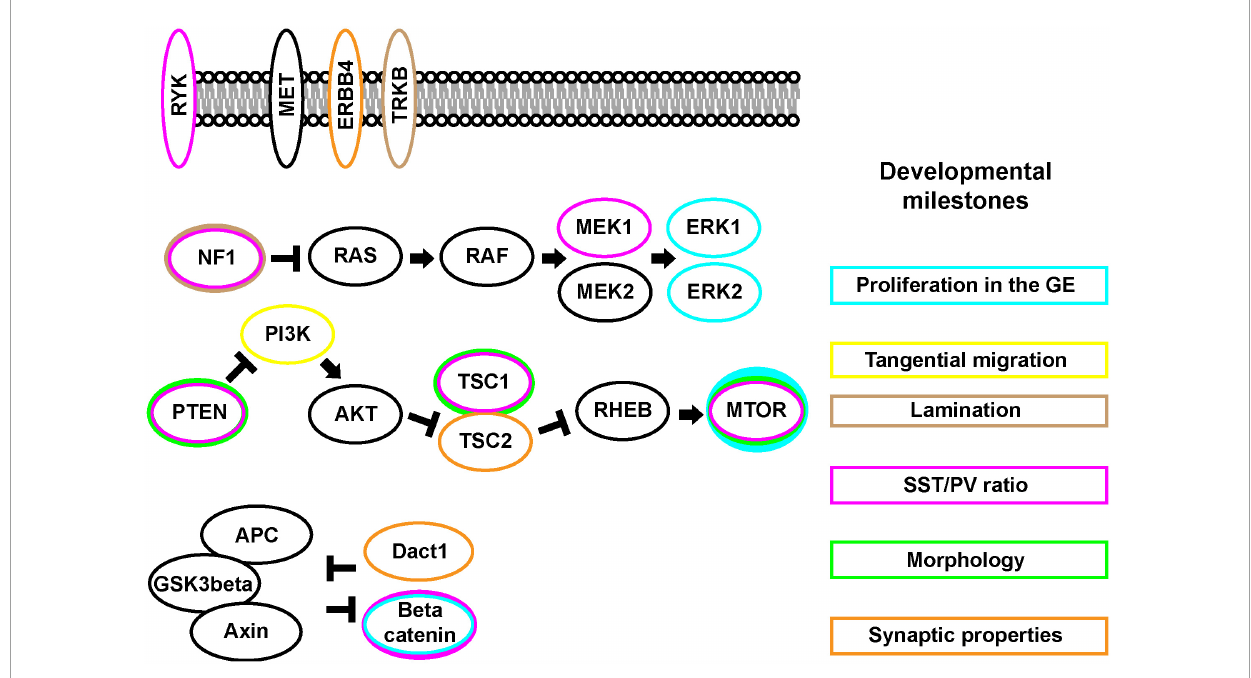
FIGURE1 The mTOR, MAPK, and Wnt/Beta-catenin signaling pathways and CIN developmental events (Right) . CIN developmental key milestones (Left) . Signaling pathway proteins. Some of these signaling proteins are found at the cell membrane while many can be found in cytosolic compartments. Each protein may exhibit differential impacts on the CIN developmental milestones, colors around each protein match to the boxes around these events.